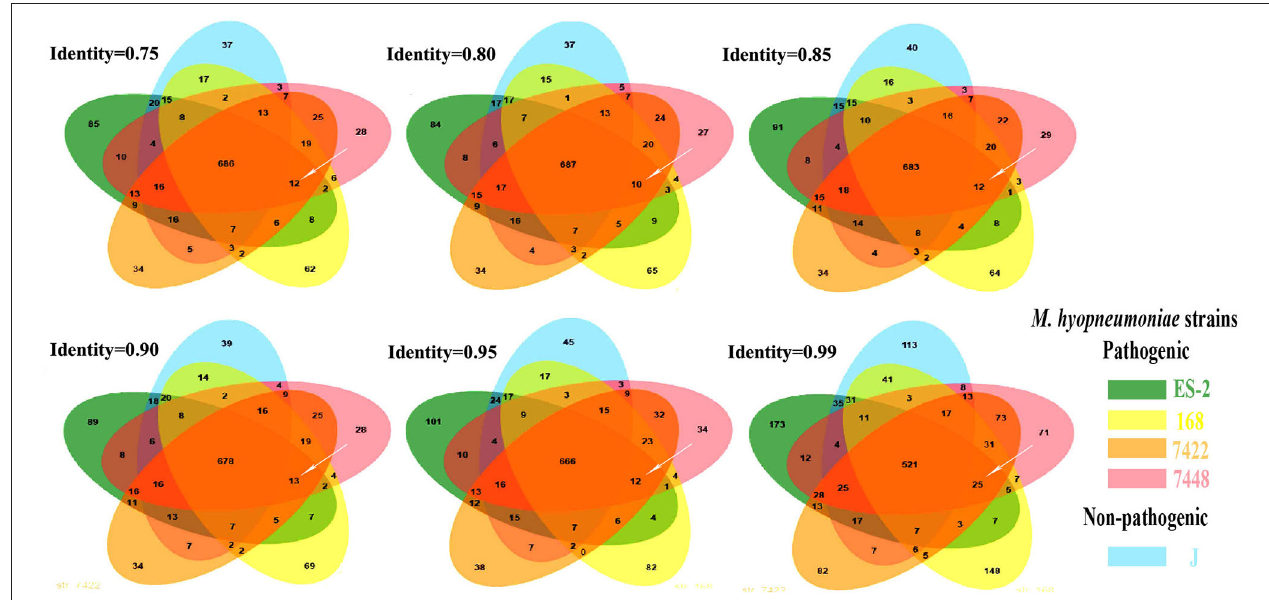
FIGURE 6 | The genes specific to pathogenic M. hyopneumoniae strains. These Venn diagrams were developed. After the genes shared by pathogenic M. hyopneumoniae (ES-2, 168, 7422, and 7448) strains and nonpathogenic M. hyopneumoniae strain J were eliminated based on different levels of identity. 12, 10, 12, 13, 12, and 25 (white arrows) genes specific to pathogenic M. hyopneumoniae strains were, respectively, showed at the levels of identity 0.95, and